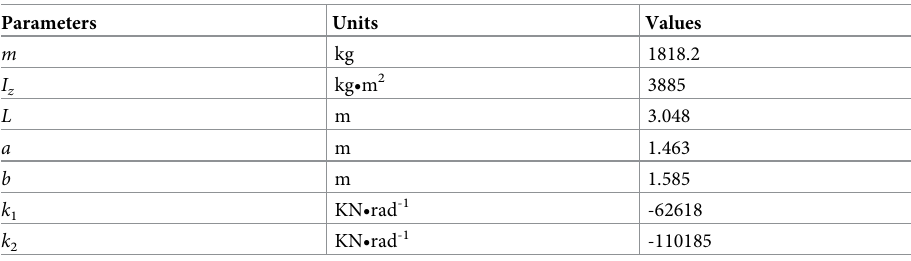
Table 1. The parameters of the tractor.